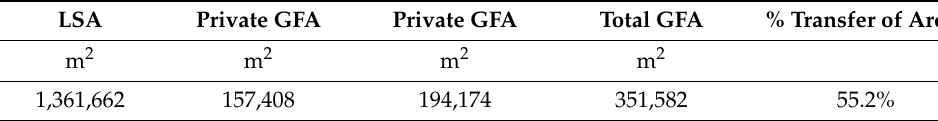
Table 2. Total building rights.